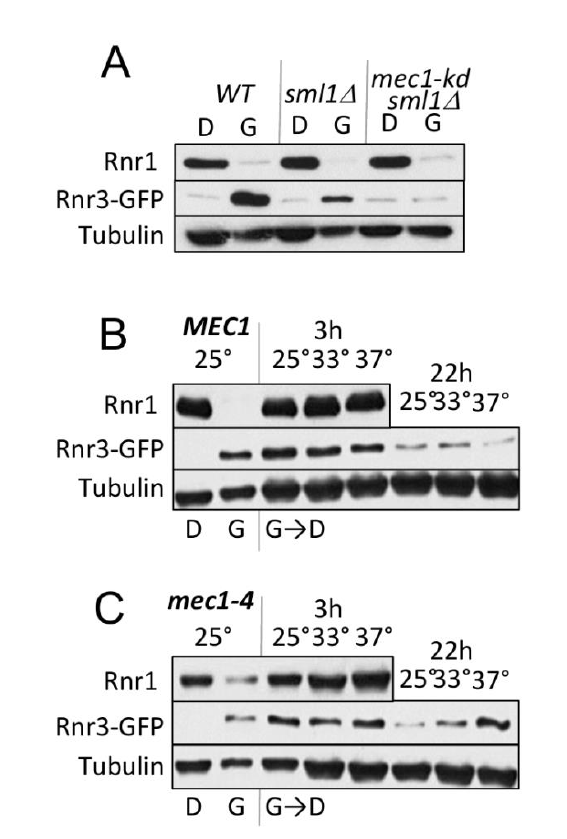
FIGURE 2: Mec1 promotes the carbon source dependent